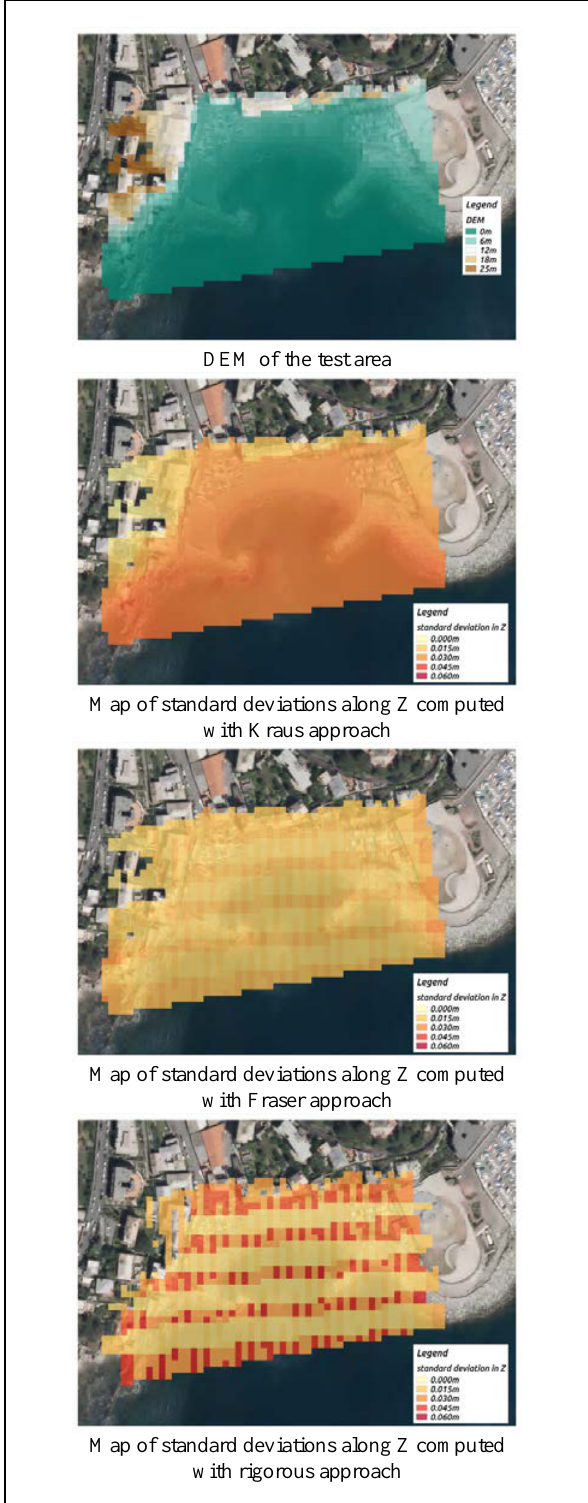
Figure 2. Maps of standard deviations along Z computed with different